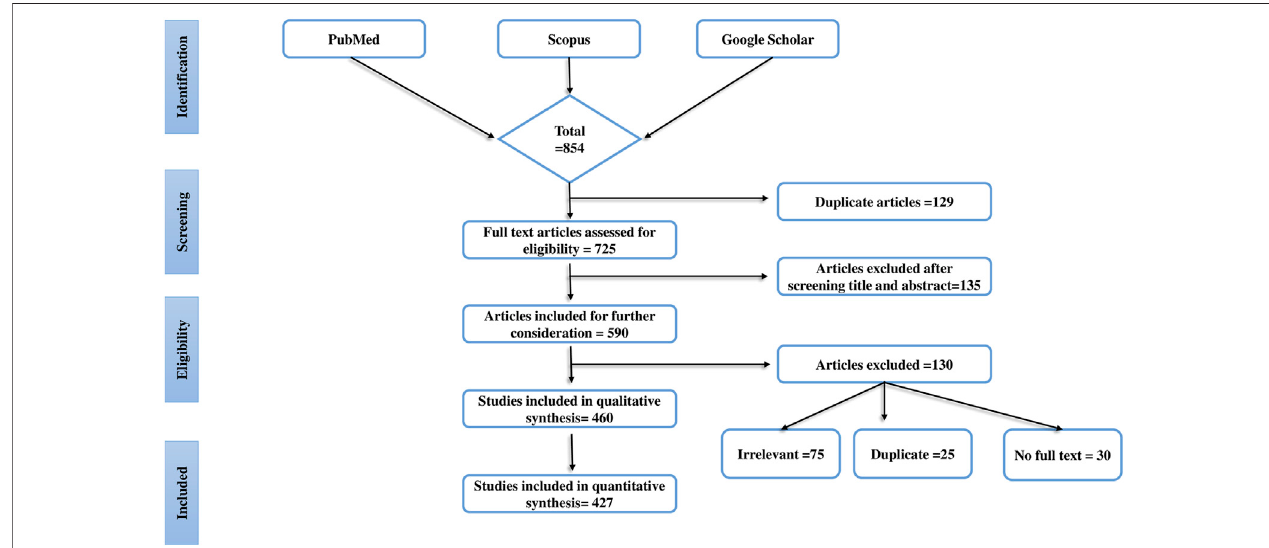
FIGURE1| Theprogressofasystematicliterature searchisshowninthis fi gure.Thesystematicliteraturesearch ’ sidenti fi cation,screening,eligibility,andinclusion procedure is detailed and use the Preferred Reporting Items for Systematic Reviews (PRISMA) fl ow chart.